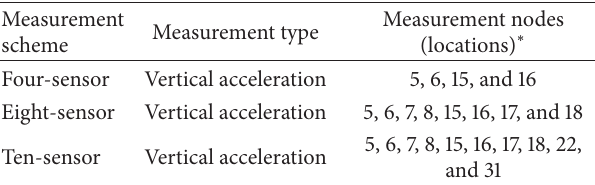
Table 2: Sensor deployment